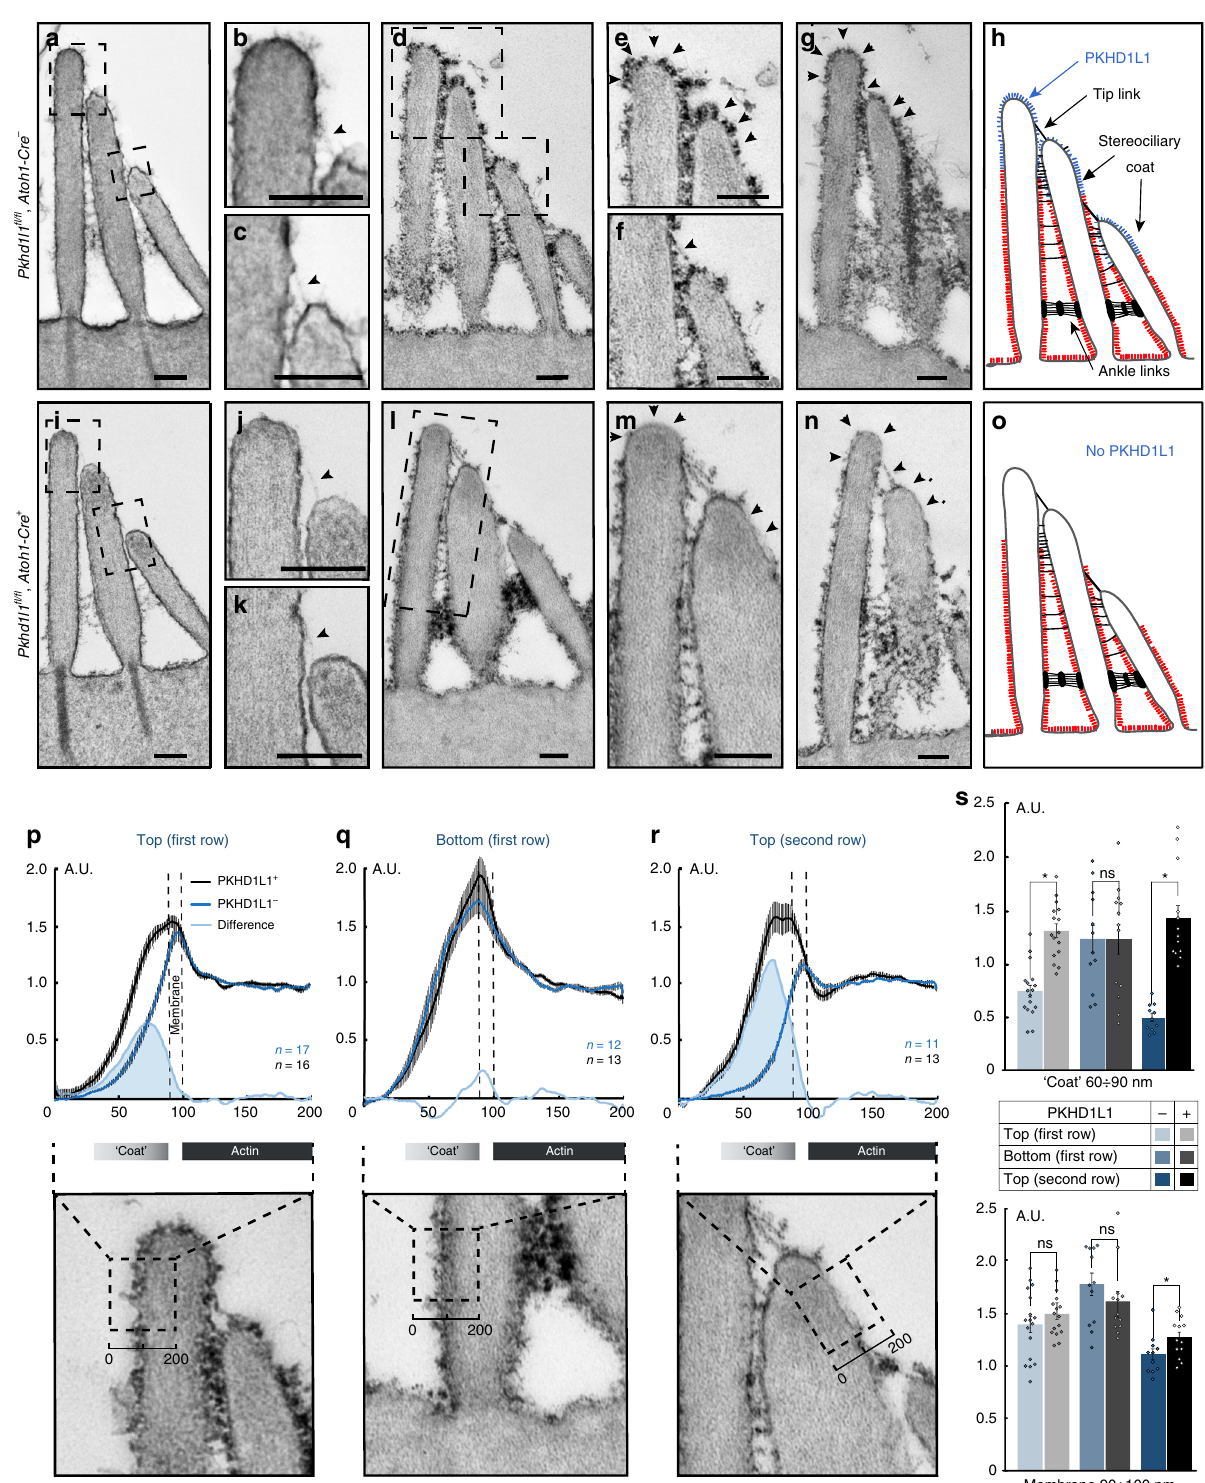
row)Top (first row)Bottom (first Top (second